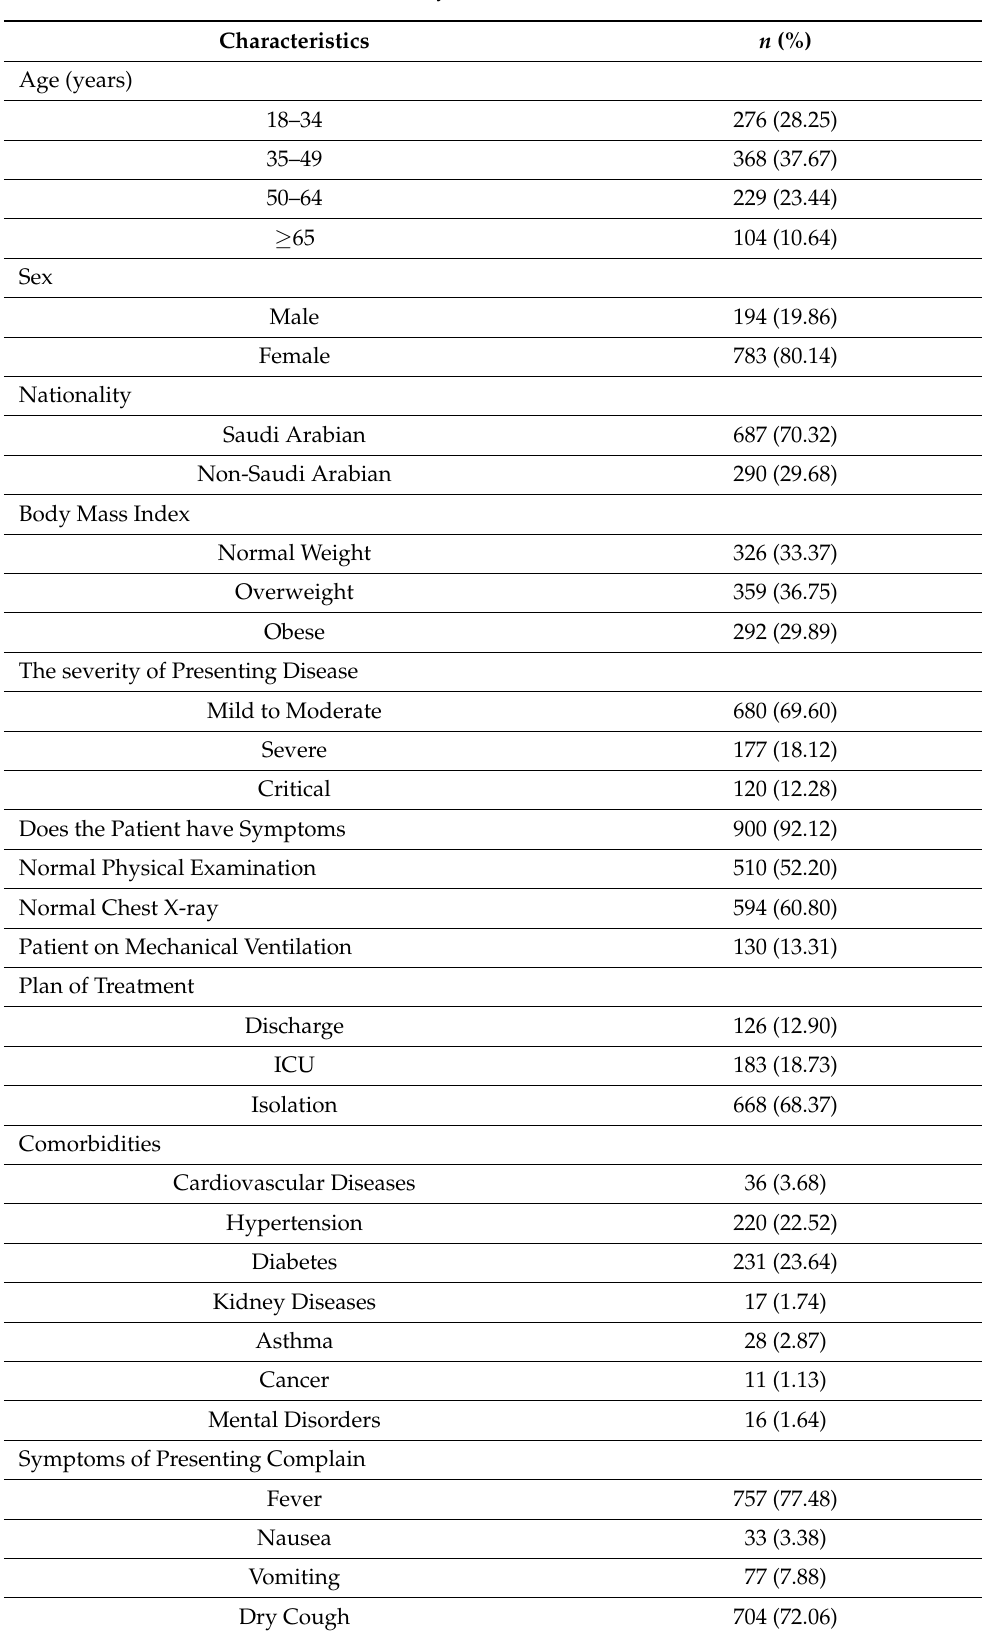
Table 1. Baseline Characteristics of the Study Patients ( n =